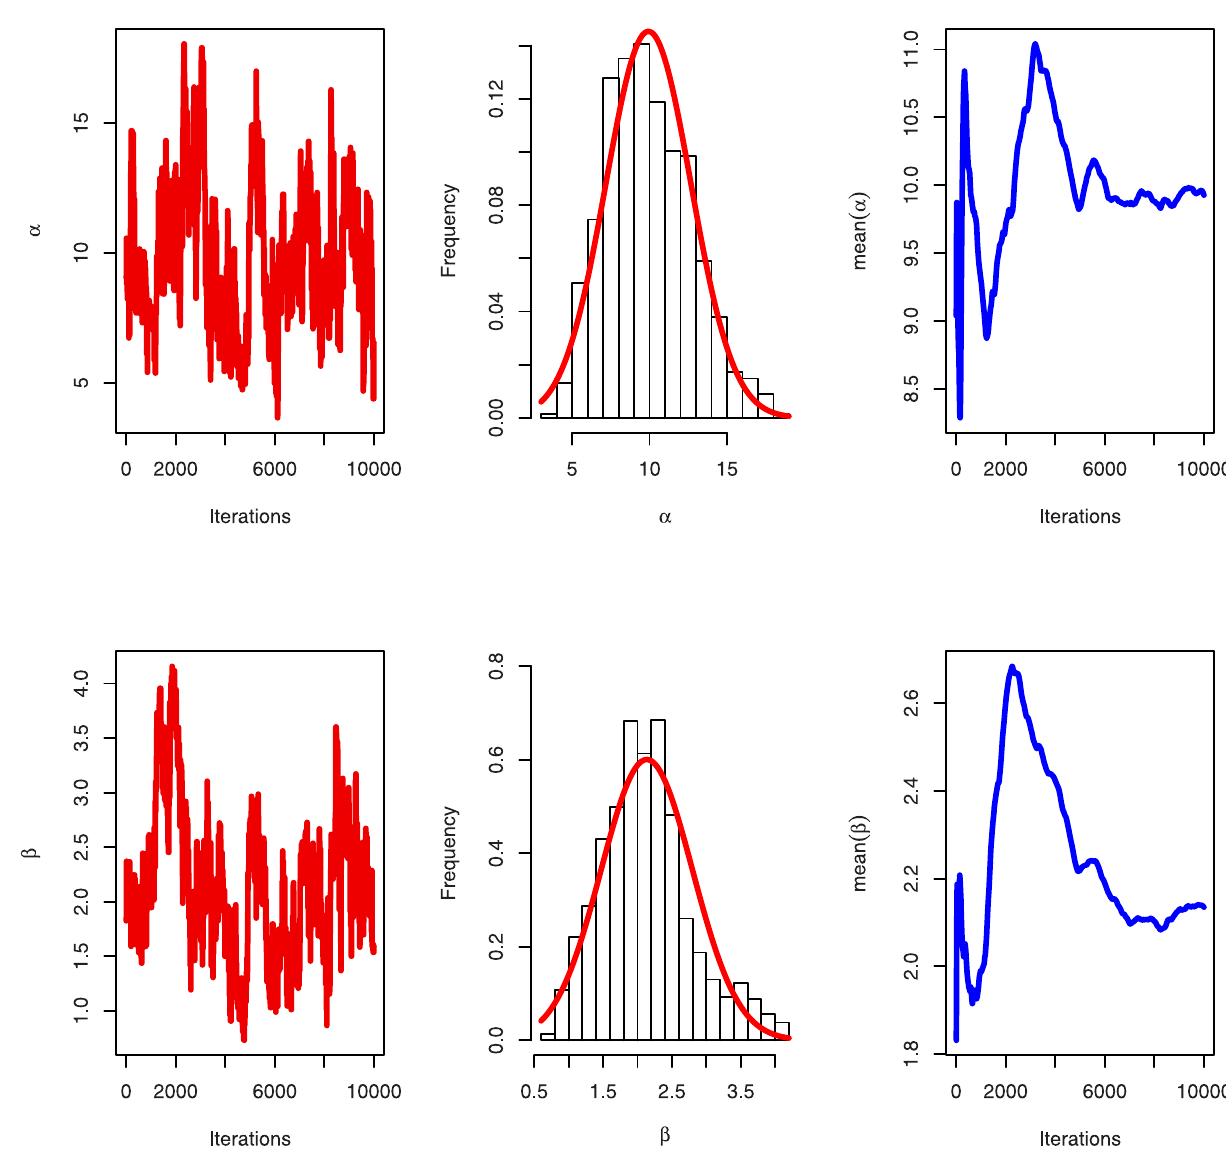
Fig 11. Convergence of MCMC estimation of OLINH distribution for COVID-19 vaccination for the parameters α , and β .